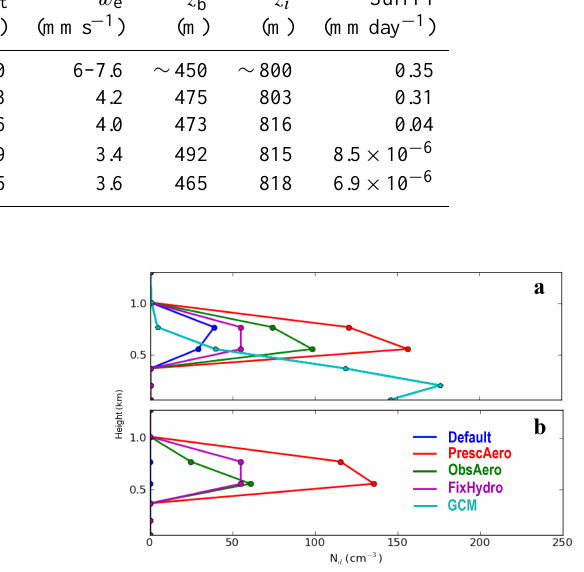
Table 2. Data averaged over the last 2h of the DYCOMS RF02 simulations. Observations are from W07. N d is the average over the in-cloud portion of all cloudy levels of the column. N d